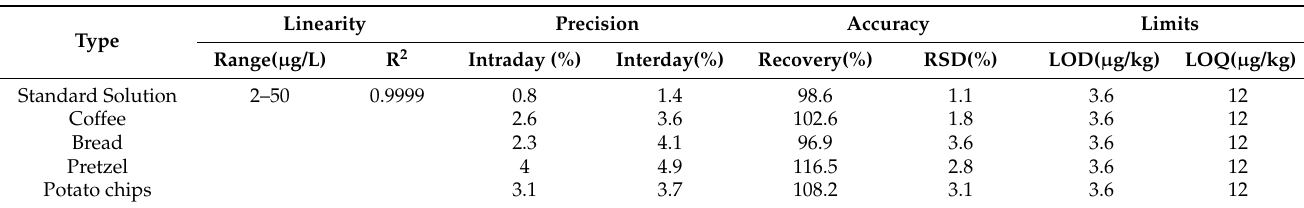
Table 1. Method validation.